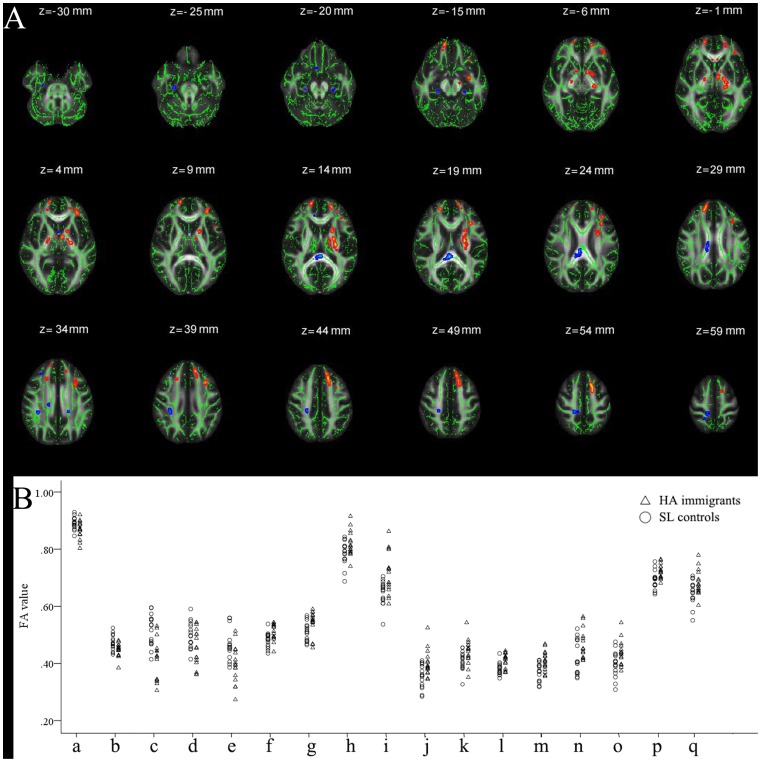
Regional changes in FA in HA immigrants compared with SL controls.(A) The group’s mean FA skeleton (green) was overlaid on the mean FA images. The threshold of mean FA skeleton was set at 0.2. (B) Scatter plots show between-group changes in these clusters.